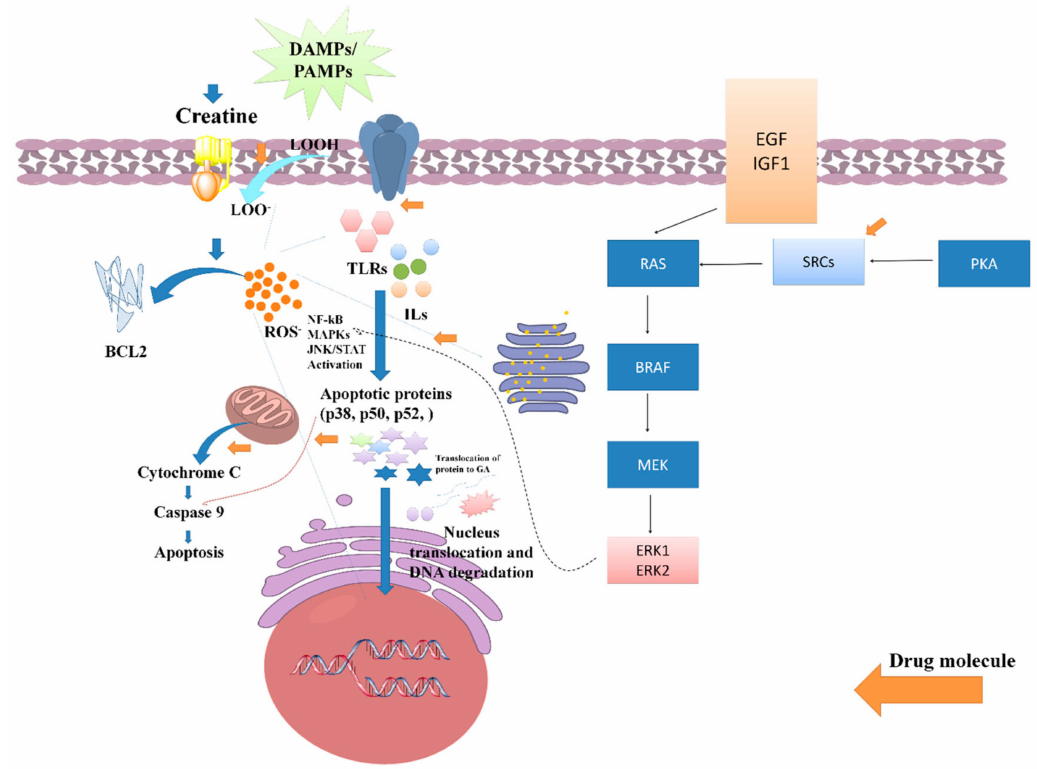
Figure 5. Role of creatine against PAMPs and DAMPs induced inflammatory stress and its impact on various signaling pathway activations such as NF-kB, MAPKs, and